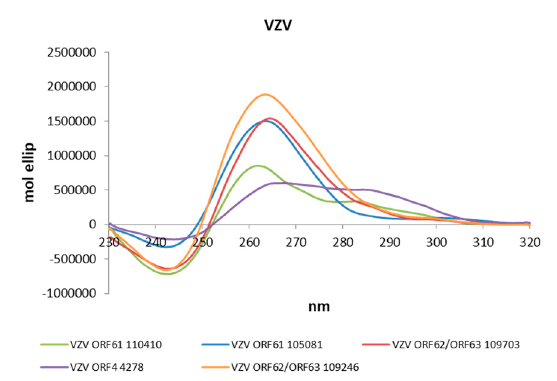
Figure 2. Circular Dichroism (CD) spectra of the PQS embedded in the Alphaherpesvirus IE promoters in PB 20 mM and KCl 70 mM.